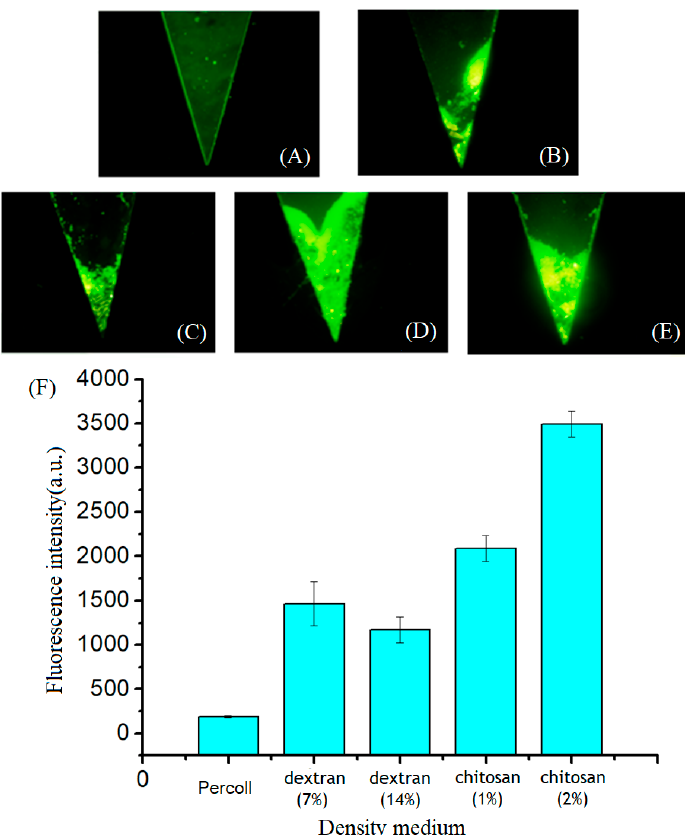
Figure 2. Effect of the dense medium on isolation efficiency in the centrifugal microfluidic platform. Separating effects of ( A ) Percoll, dextran (( B ) 7% or ( C ) 14%), and chitosan (( D ) 1% or ( E ) 2%) as dense media and ( F ) their histogram comparison.